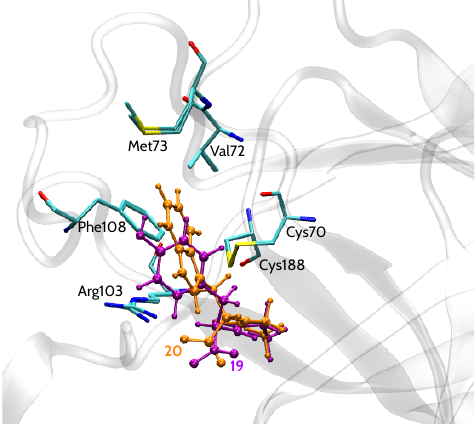
Figure 1. EphA2 binding site representation with bound inhibitors 19 ( D -Tyr) and 20 ( L